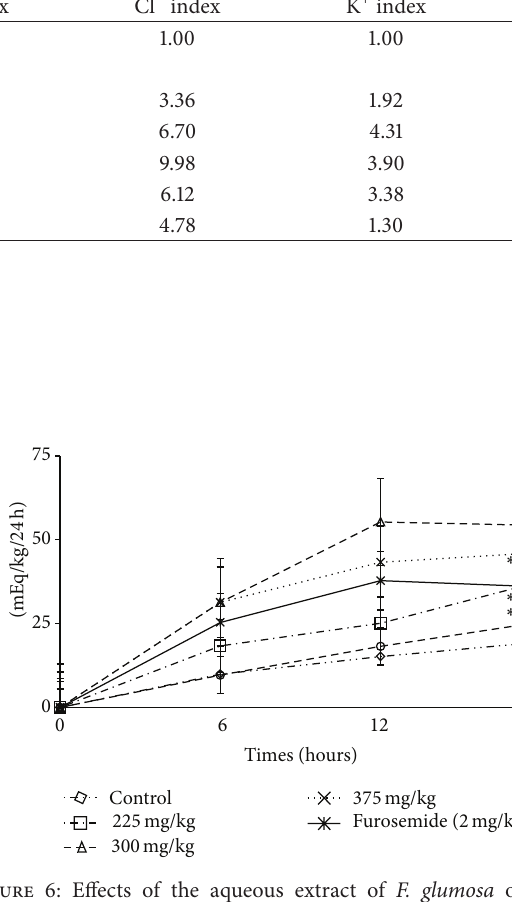
Figure 4: Effects of the aqueous extract of F. glumosa on the cumulative Na + excretion. Values are means ± SEM, 𝑛 = 5 , ∗ ∗ ∗ < 0.001 , significant difference compared to the control.